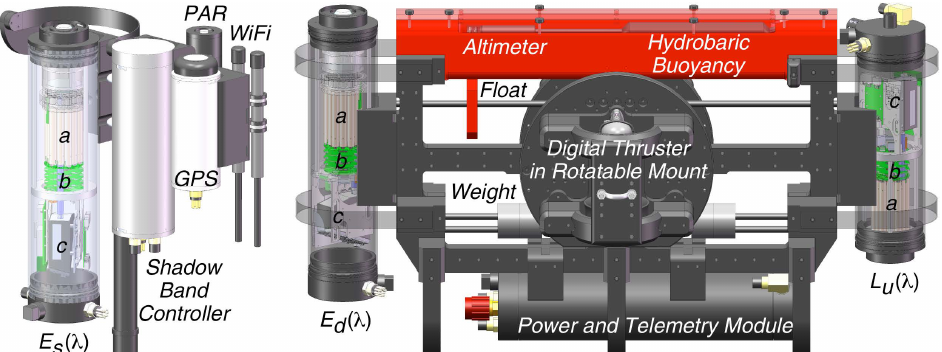
Figure 2. The instruments mounted on a mast affixed to SV3 cover plate ( left ) and the TOW-FISH ( right ). Transparency allows internal radiometer components to be identified, as follows: ( a ) cluster of 18 microradiometers; ( b ) support electronics; and ( c ) the spectrometer that has a rigidly affixed optical fiber that routes through the microradiometer array as the nineteenth position in the aperture. The TOW-FISH has two digital thrusters (one on each side) with harness connections so tow forces act on the backplane metacenter, up to four hydrobaric buoyancy bladders to control near-surface loitering, and planar trim is set by adding floats and weights, as well as adjusting radiometer orientation.